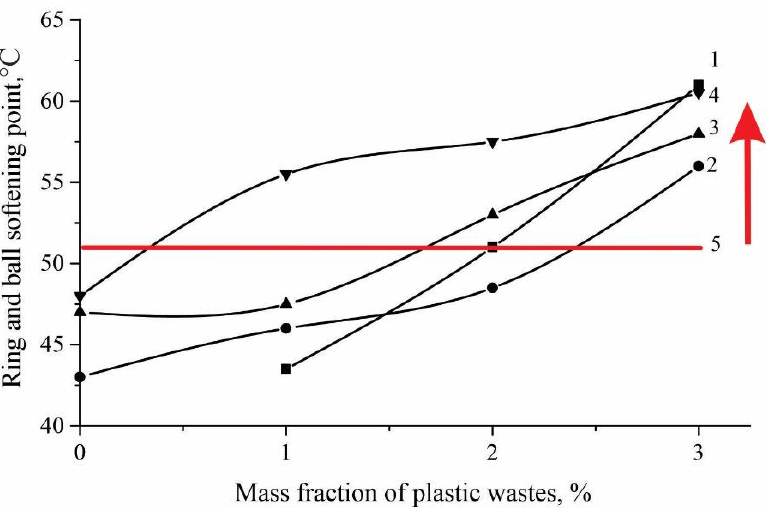
2—SBS 1%; 3—SBS 2%; 4—SBS 3%; 5—according to Figure 3. Change in softening temperature from polymer waste concentrations. 1 — without SBS; 2 — SBS 1%; 3 — SBS 2%; 4 — SBS 3%; 5 — according to Standard.